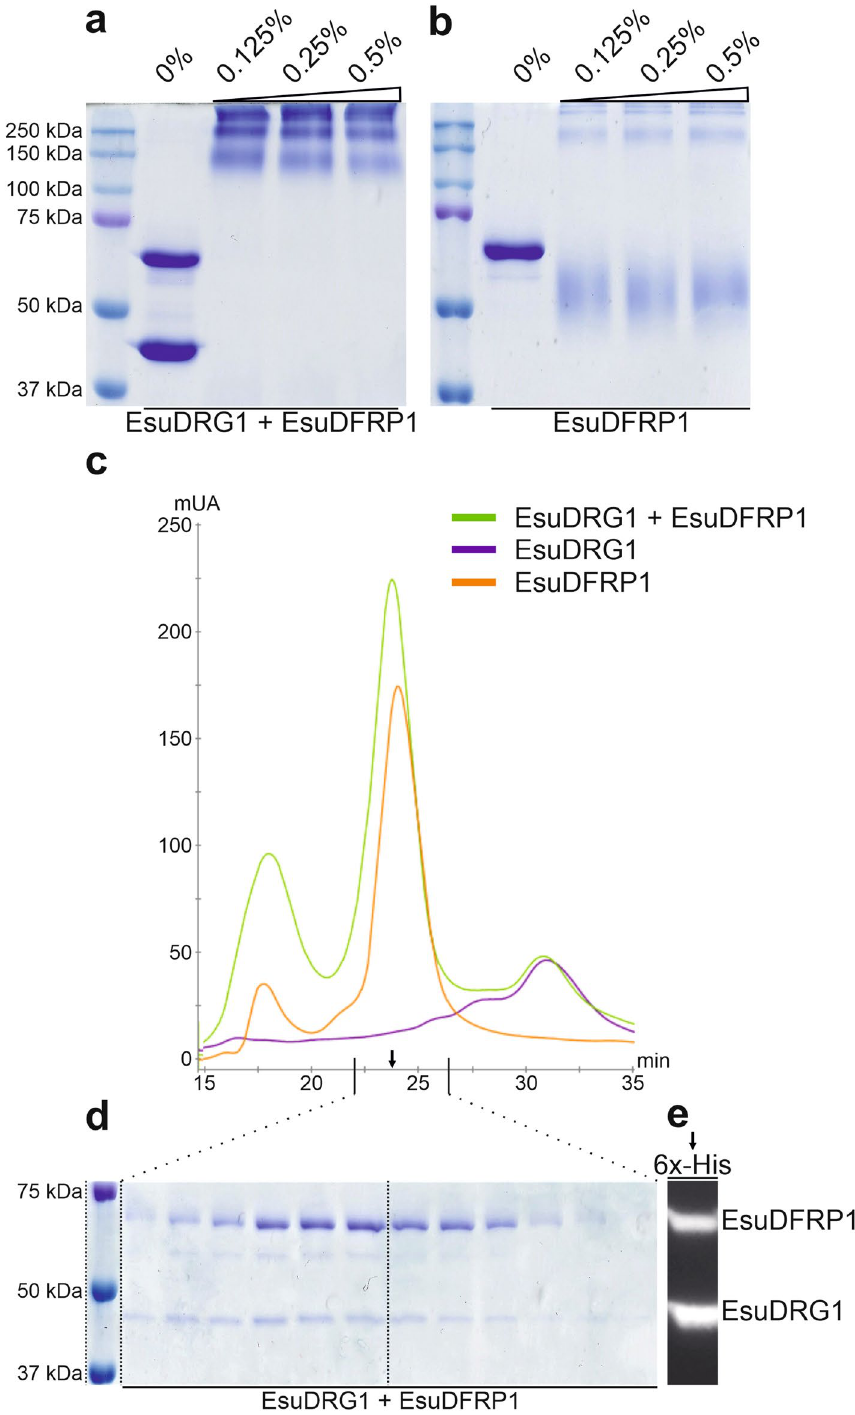
Figure 5. Sponge DRG1 and DFRP1 form heterooligomers. ( a ) Crosslinking of EsuDRG1 + EsuDFRP1 and ( b ) EsuDFRP1 alone. Glutaraldehyde was added up to a final amount of 0.5%. Reactions were incubated at 25 °C for 30 min. ( c ) SEC of EsuDRG1 protein (purple line), EsuDFRP1 protein (orange line) and a mixture of EsuDRG1 + EsuDFRP1 proteins (green line). ( d ) Selected fractions of potential DRG1 + DFRP1 complexes (at retention time 22–26 min) were analysed by Coomassie Brilliant Blue staining. ( e ) Western blot of selected fraction of EsuDRG1 + EsuDFRP1 (indicated by arrow) against His-tag. Original gels and blots are presented in Supplementary Fig.